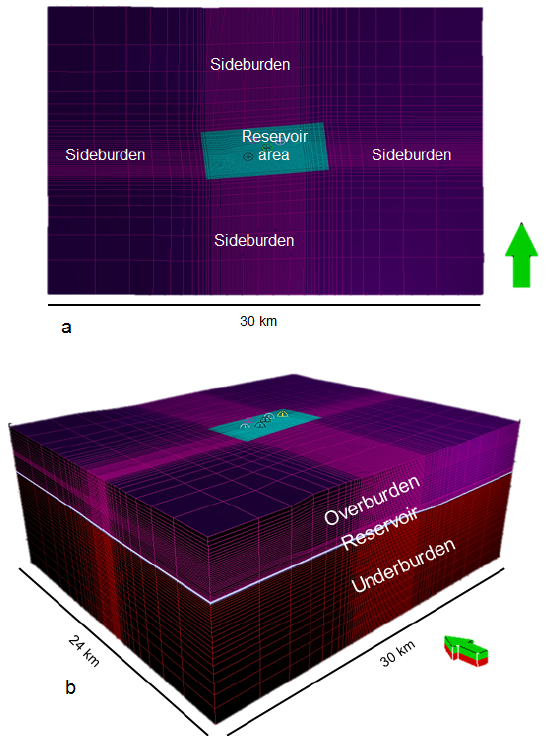
Figure 1. Reservoir model proper embedded in 3D geomechanical model with reservoir, overburden, underburden, and sideburden zones: ( a ) is the top view, and ( b ) is the oblique view, the arrows represent north direction [10].